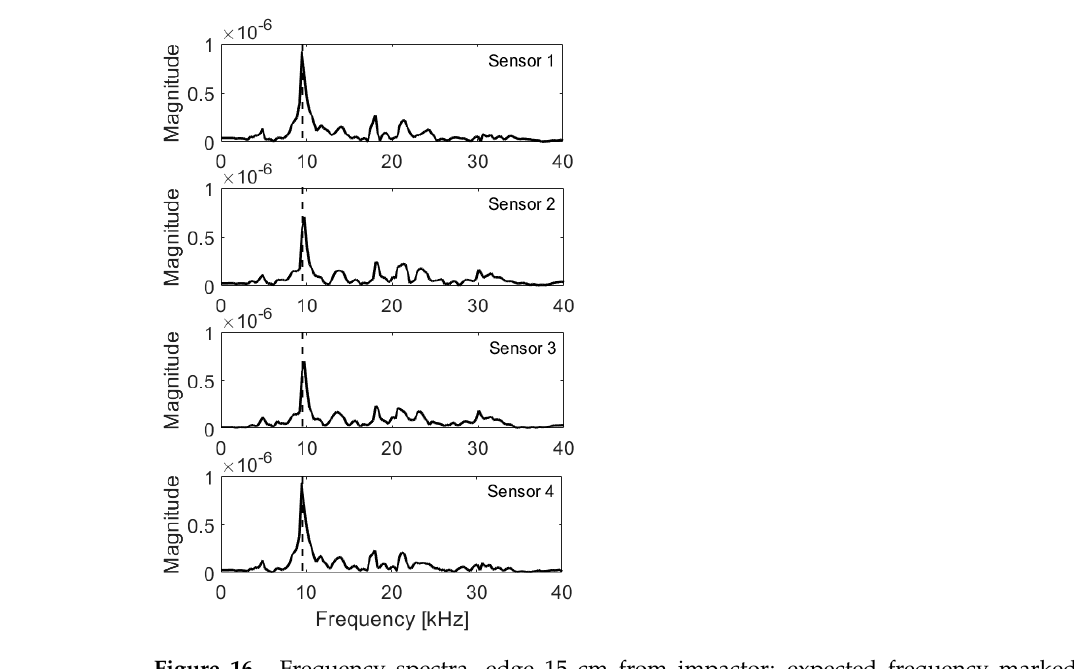
Figure 15. Scheme of void and IE device layout, edge 15 cm from impactor.